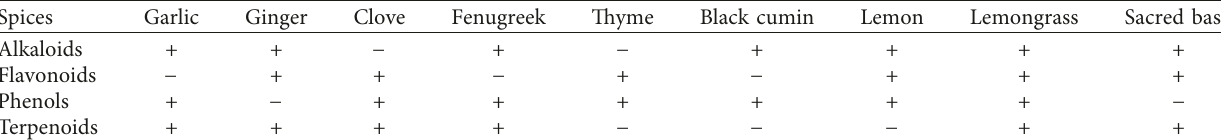
Table 2: Phytochemical test results of eight tested